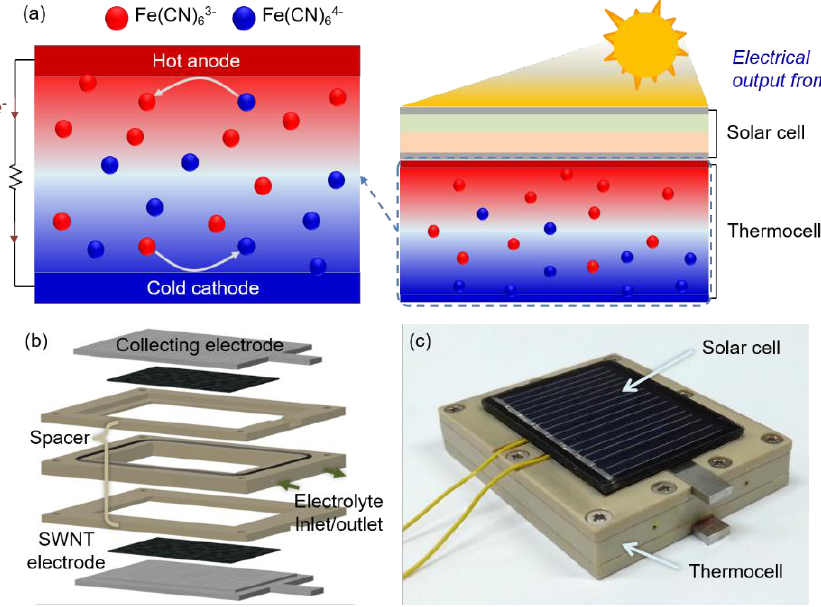
Figure 1. Fabrication and operation of the hybrid photovoltaic/thermocell (PV/T) module; ( a ) Schematic of the hybrid PV/T module and the thermocell operation; ( b ) Cell components and their assembly in a thermocell; ( c ) Optical image of the fabricated PV/T